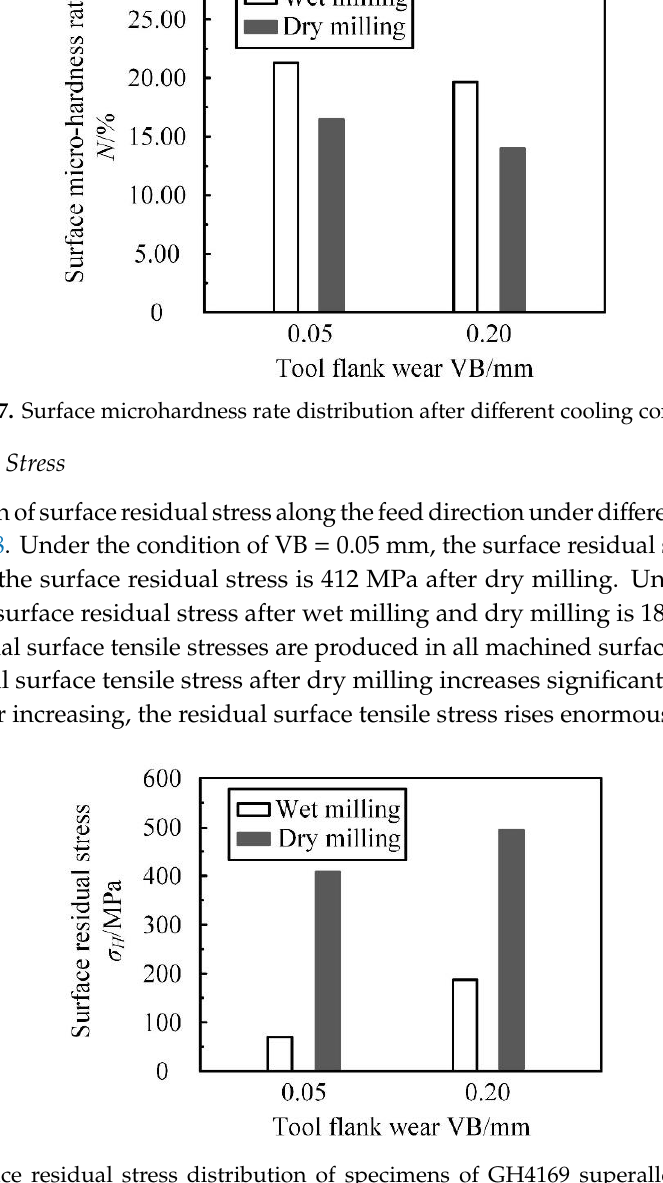
Figure 8. Surface residual stress distribution of specimens of GH4169 superalloy after different milling conditions.